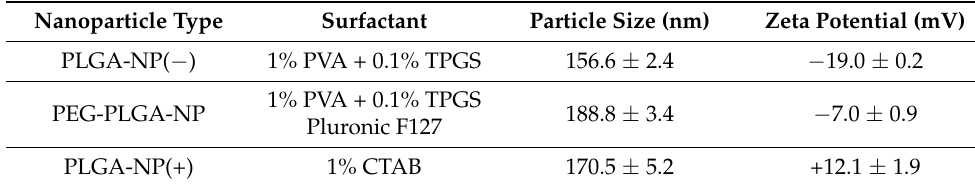
Table 1. Physicochemical properties of